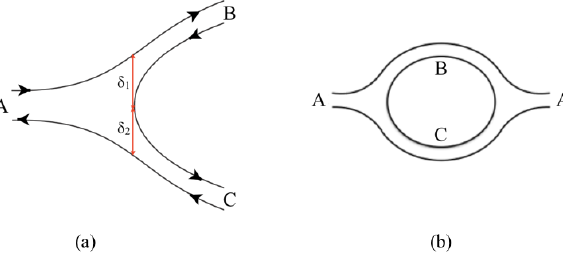
B , C A , “string breaking”, is determined by the wave functions of hadrons (cid:31) | (cid:29)